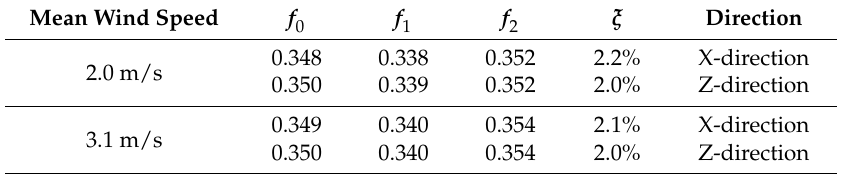
Table 4. Natural frequency and damping ratio of the OWT in parking